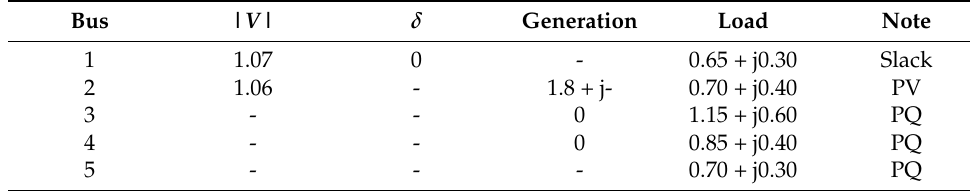
Table 4. Test system bus data (in pu).